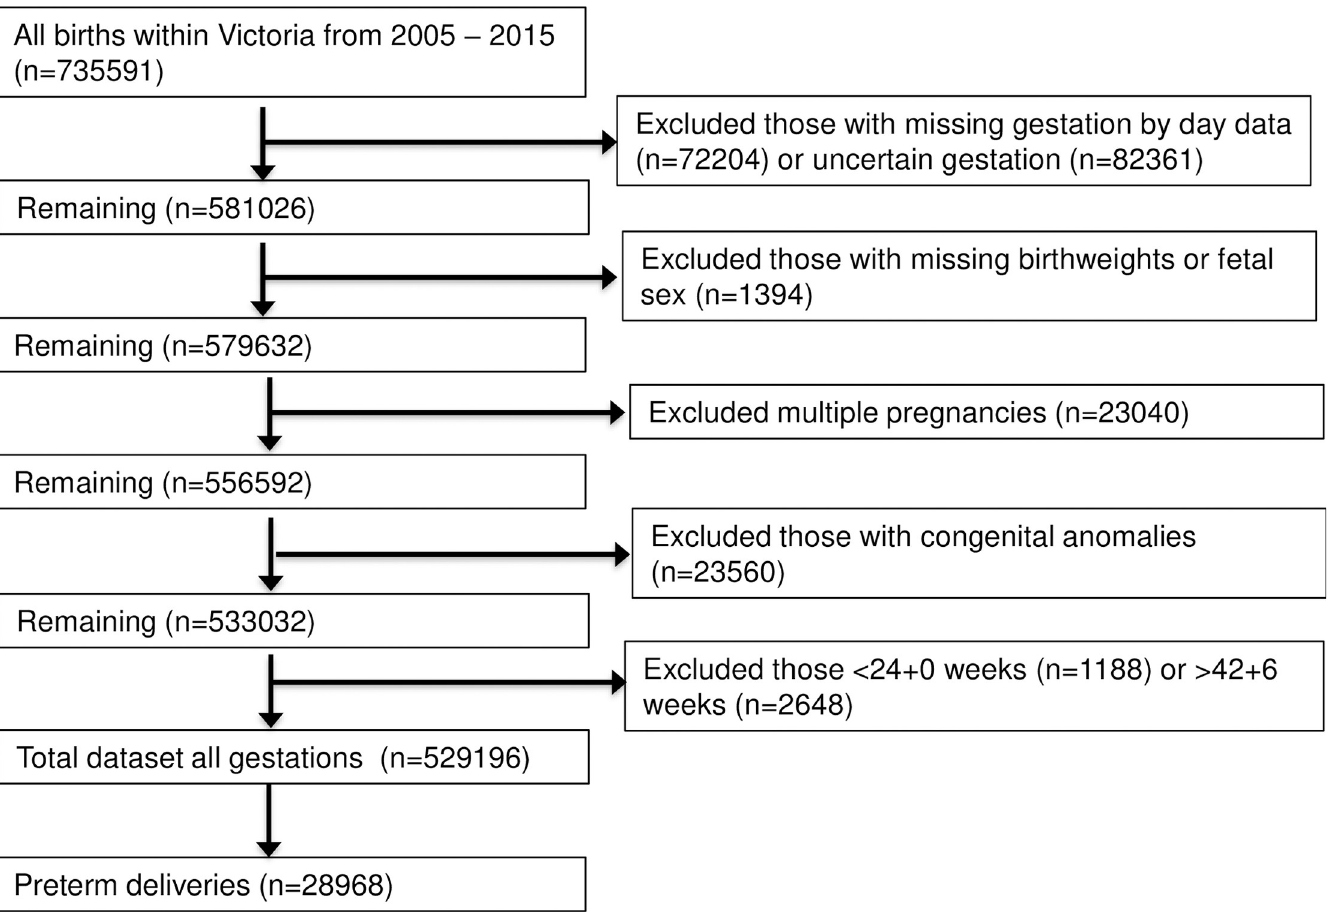
Fig 1. Flow diagram of exclusion